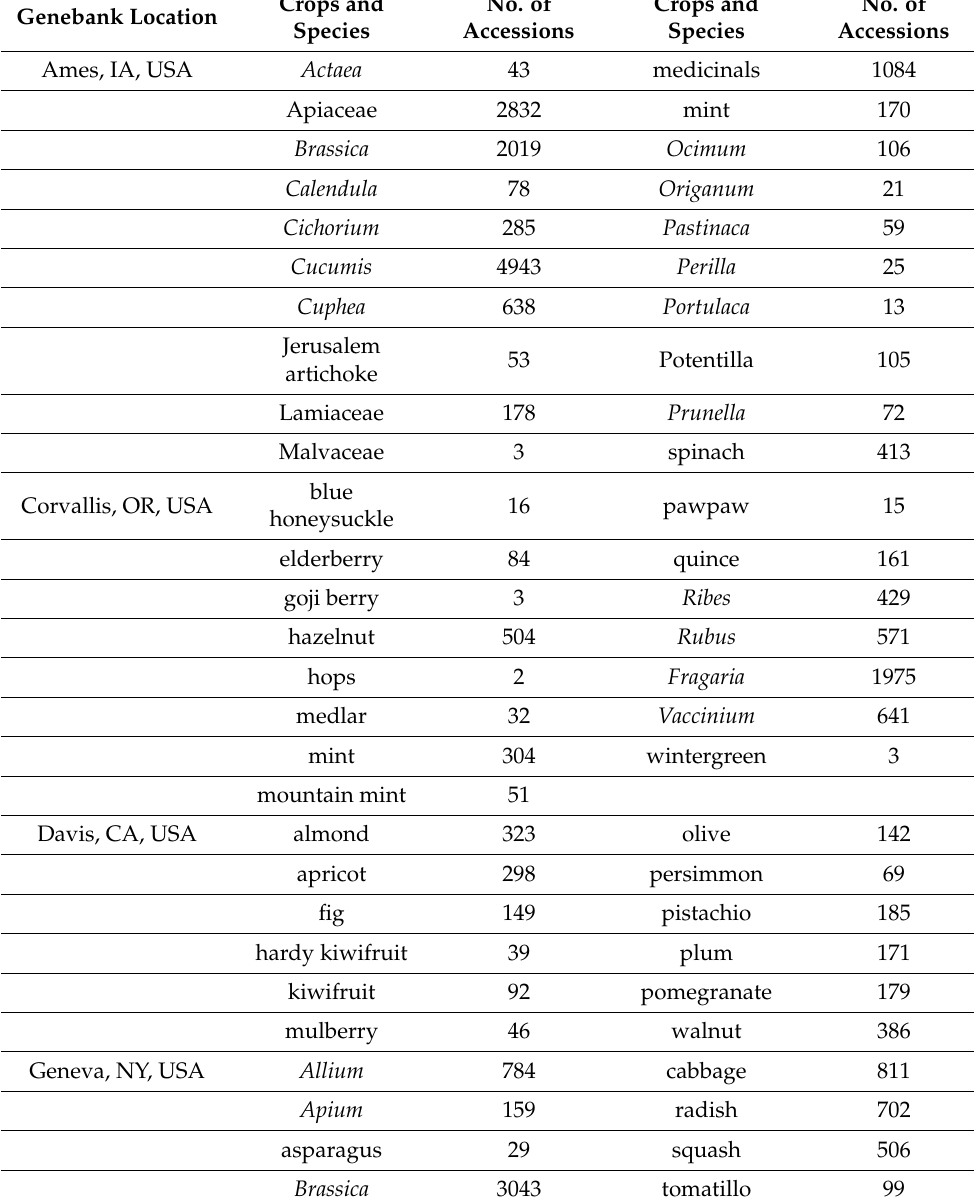
Table 3. A partial list of collections of seeds and vegetative propagules of plant species considered to in this paper to include specialty horticultural food crops maintained at USDA/NGS Plant Introduction Stations and Germplasm